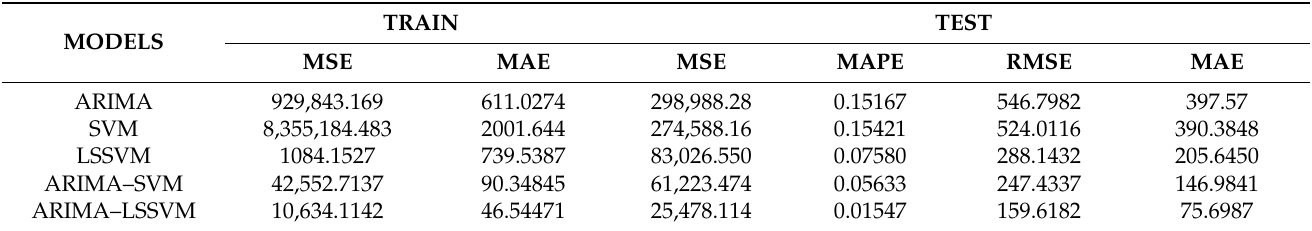
Table 5. Performance measures of the proposed model for daily new positive COVID-19 cases datasets.